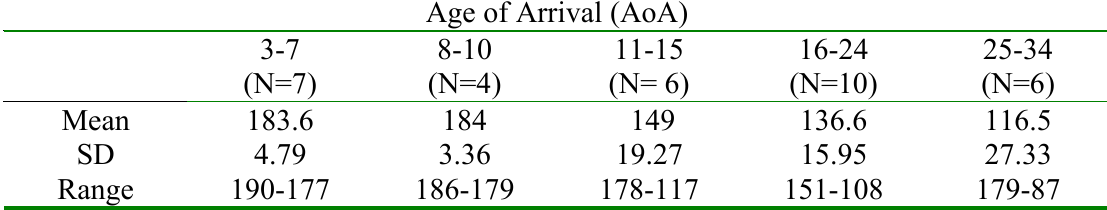
Mean, Standard Deviation, and Range of Correct Items on Grammaticality Judgment Test for Five Age